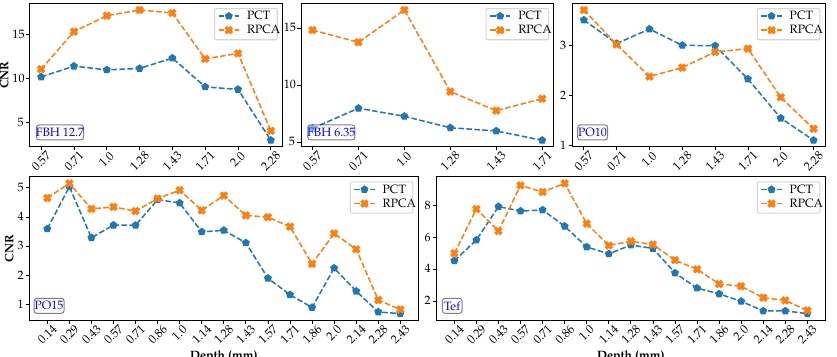
Figure 10. CNRmax by defect type as a function of the defect depth for all data sequences (PCT and RPCT).